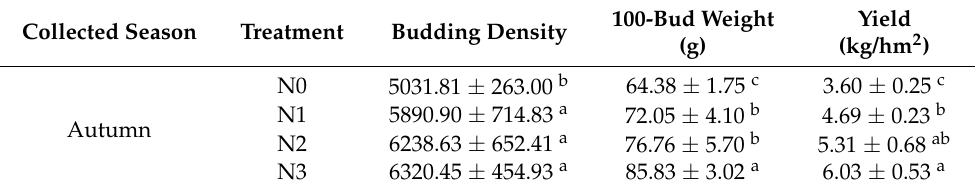
Table 2. Effect of long-term nitrogen application on budding density, 100-bud weight, and yield of autumn